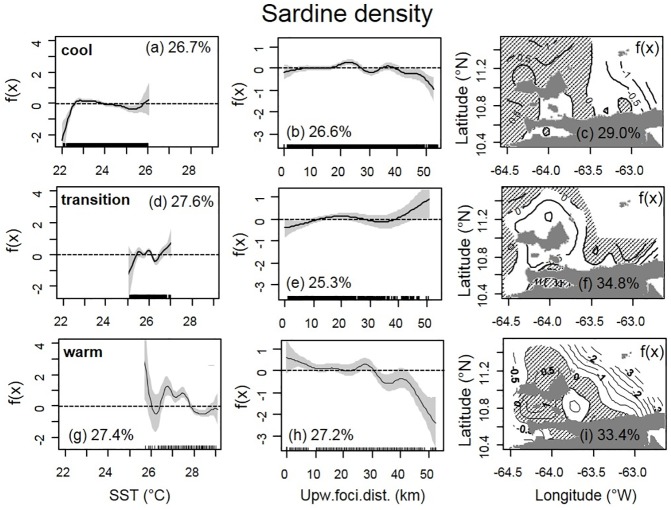
GAM analysis of sardine-NASC vs. SST, distance from upwelling foci, and location for different seasons.Univariate GAM analysis of log(sardine-NASC) vs. SST, distance from upwelling foci, and Location (longitude, latitude) for: Cool (top a, b and c, VECEP 2, 3, 5, 6 and 8), Transition (middle d, e and f, VECEP 4), and “Warm” (bottom g, h and i, VECEP 1 and 7) conditions. The y-axes (and the isolines in the map) show relative changes of the environmental variable on sardine-NASC, f(x), so that a value of zero represents the mean effect. Positive isolines in Location are highlighted with hashed lines. Each parameter has similar scales to contrast its importance between different upwelling conditions. For SST and foci distance the values where the data lay is marked on the x-axis (rugplot). The 95% confidence intervals are grey-shaded for SST and foci distance. All terms were significant (p<0.01) and the sardine-NASC ‘percentage of deviance explained’ (analogous to variance in a linear regression) are shown for each term.